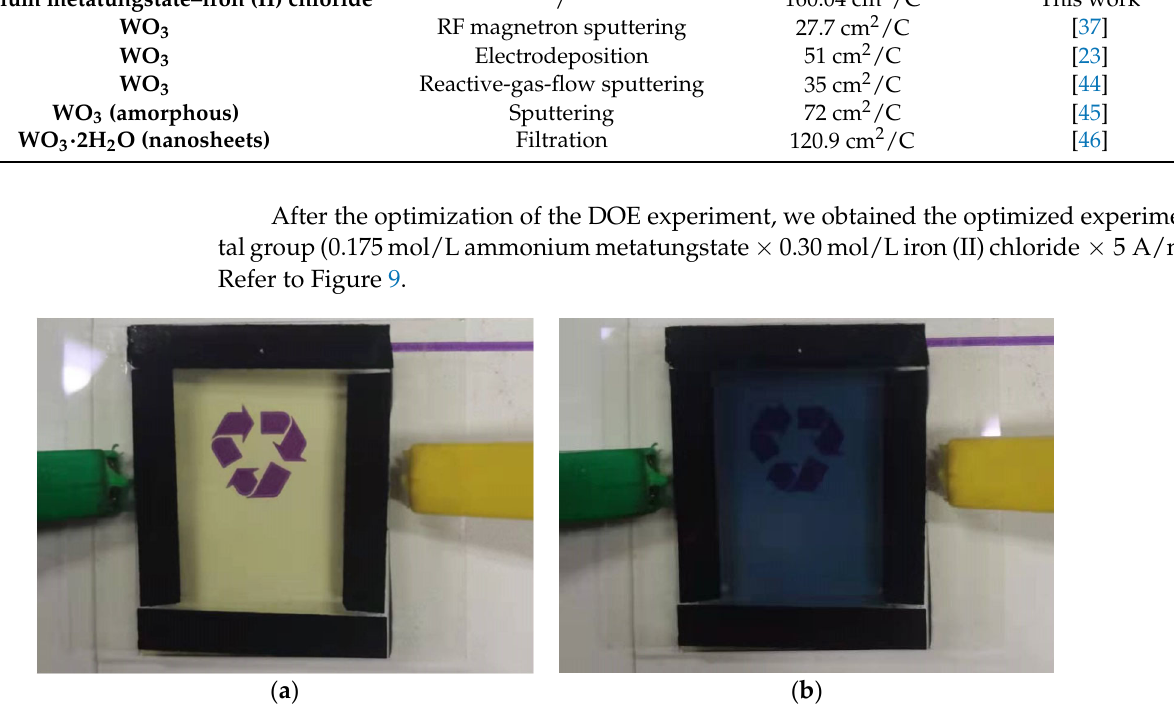
Figure 9. ( a ) Optimized experimental group in the colored state; ( b ) optimized experimental group in the faded state. in the faded